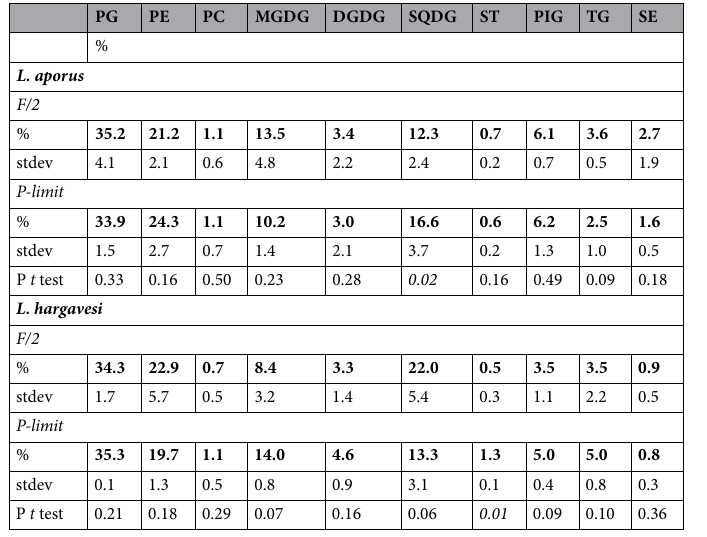
Table 3. L. aporus and L. hargravesii cellular lipid classes distribution (%) for the F/2 and P-limit conditions. In general, there were no significant differences ( P > 0.05) between the cells grown in F/2 and in P-limit medium. Exceptions were SQDG for L. aporus and ST for L. hargravesii. Significance values of P t test are in bold and